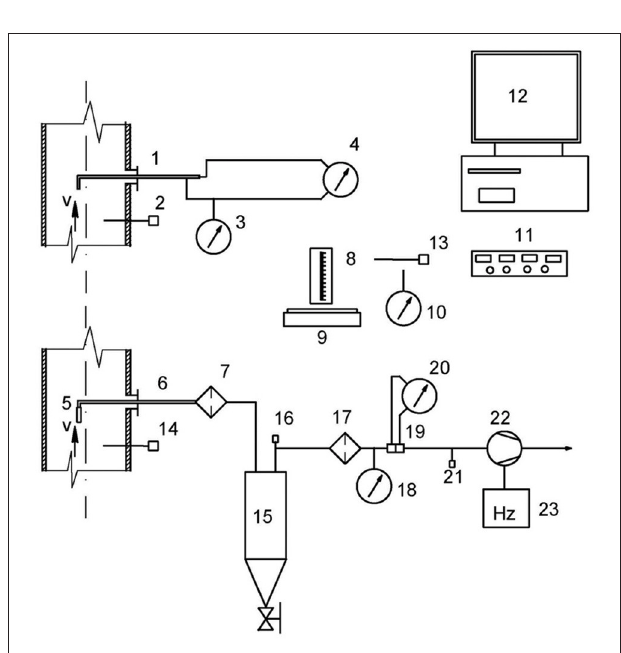
FIGURE 3 | Particulate Capture Schematic: 1. Prandtl tube, 2. Thermocouple, 3. Manometer for measuring static pressure, 4. Manometer for measuring differential pressure, 5. Nozzle sampling probes, 6. Sampling probe, 7. Heating filter, 8. Lab bulb, 9. Weight measurement, 10. Manometer for atmospheric pressure, 11. Data capture module, 12. PC for data recording, 13. Thermocouple for ambient temperature, 14. Thermocouple, 15. Condenser, 16. Thermocouple exit gas from condenser, 17. Filter to protect the pump, 18. Manometer for measuring the static pressure at the condenser, 19. Aperture, 20. Manometer for flow measurement, 21. Manometer behind the aperture, 22. Vacuum pump, 23. Frequency